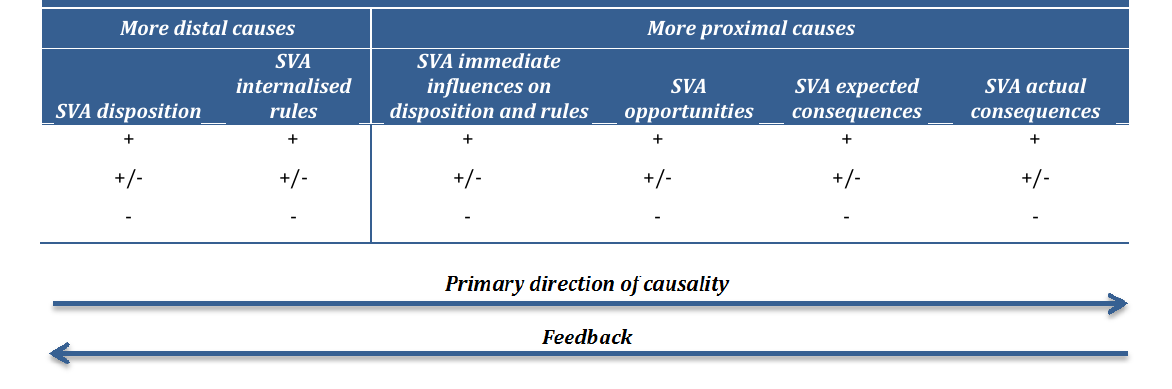
Figure 1: Causal model for endemic sexual violence and abuse (a) The overall influence of broader ecological systems is important Note: ‘+’ refers to causal forces favouring sexual violence and abuse; ‘+/‐’ refers to ambiguity in causal forces favouring or inhibiting sexual violence and abuse; ‘‐’ refers to causal forces inhibiting sexual violence and abuse. Endemic sexual violence and abuse Conflict